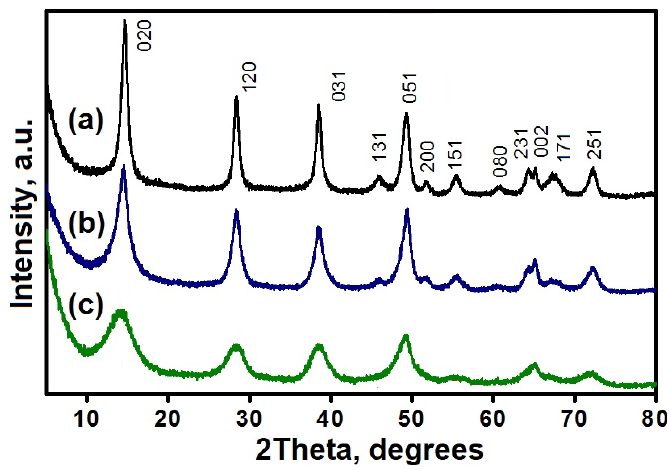
Figure 3. Boehmite X-ray patterns: ( a ) Sample TR KNT Group; ( b ) Sample Sasol SB; sample; ( c ) Sample PR KNT Group.